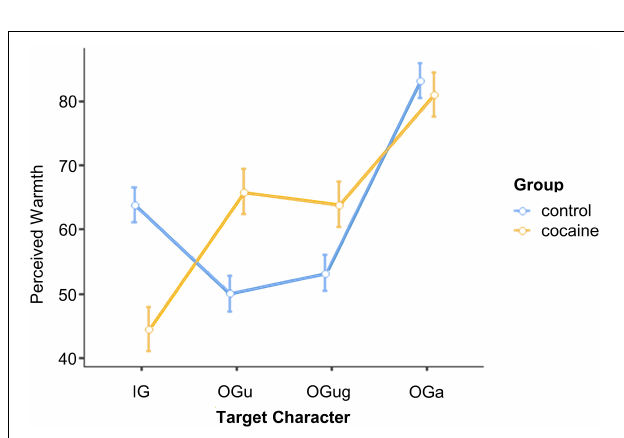
FIGURE 2 | Identification with the social targets. IOS, Inclusion of Other in the Self Scale; IG, in-group; OG u , out-group use; OG ug , out-group use + gender; OG a , out-group age. Error bars, standard errors.